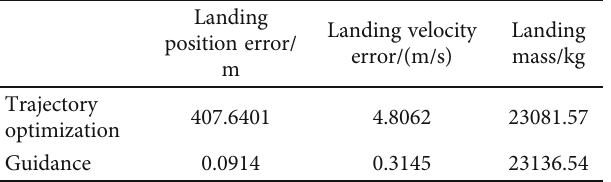
Table 5: Landing errors and masses under the condition that thrust cannot change continuously.